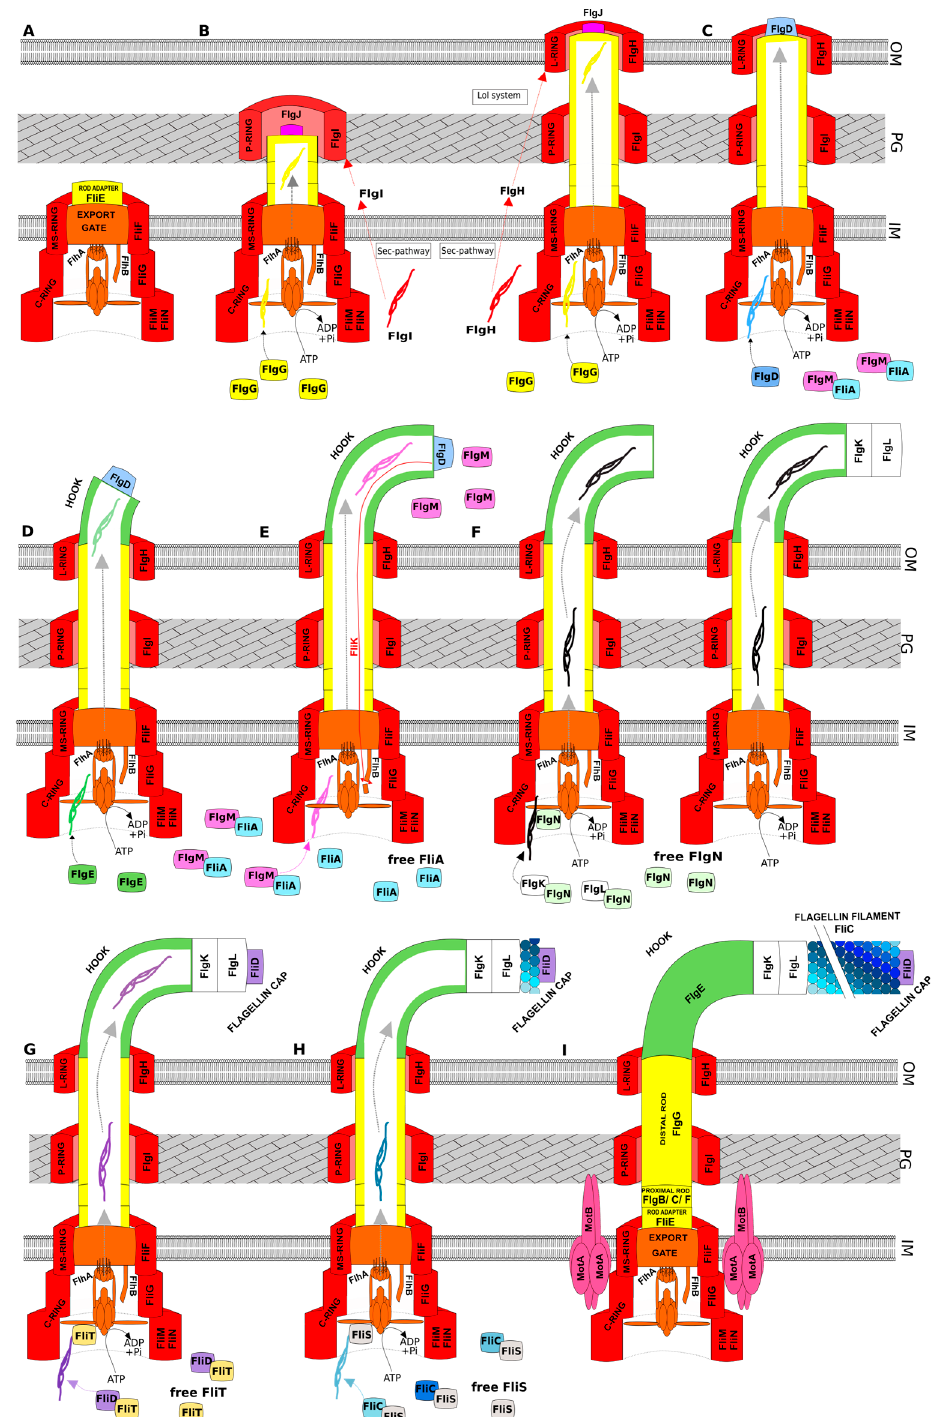
Figure 2. Schematic representation of flagellar assembly in nine arbitrary steps. IM: inner membrane, PG: peptidoglycan, OM: outer membrane. ( A ) Formation of the membrane complex and proximal rod. ( B ) Rod extension and P- and L-ring formation. ( C ) Hook cap protein insertion. ( D ) Hook extension. ( E ) Hook completion, substrate specificity switch, and FlgM secretion. ( F ) Junction protein addition. ( G ) Flagellin cap insertion. ( H ) Extension of the flagellin filament. ( I ) Insertion of the stator